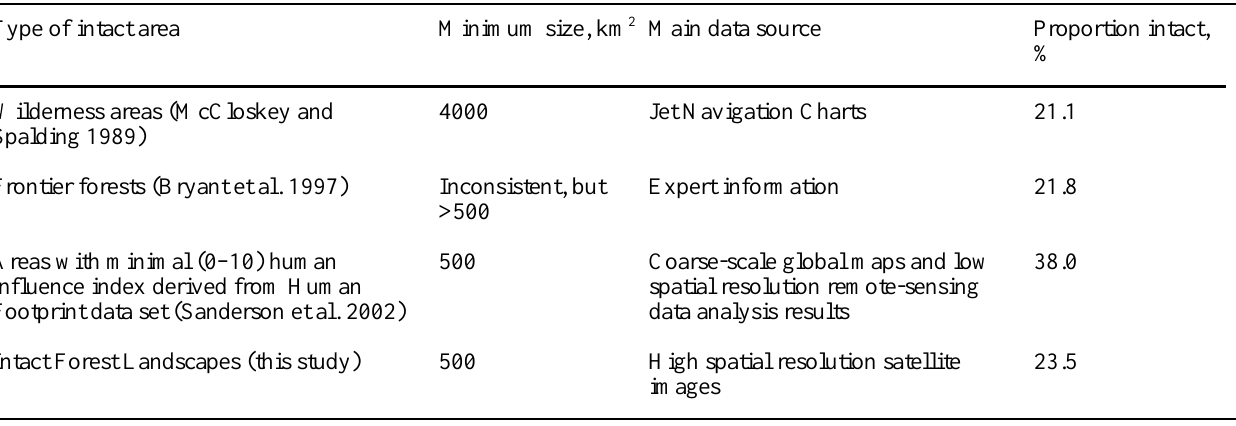
Table 2. Comparison of different assessments of the world’s intact forest area (within the forest zone).